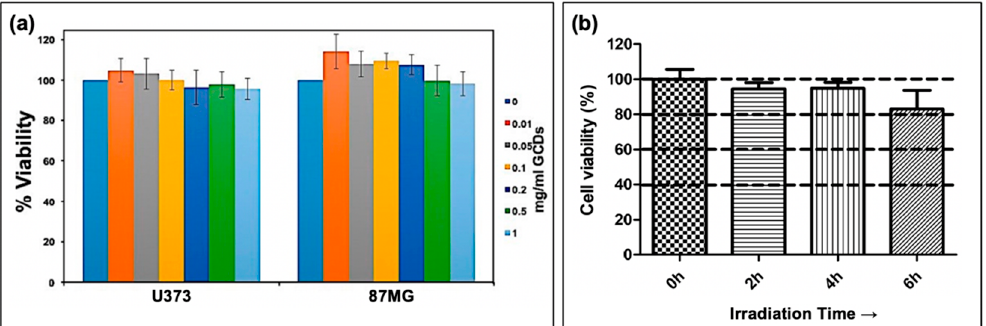
Figure 14. Example cytotoxicity data from carbon nanodot samples. ( a ) Concentration-dependent viability of Glioblastoma cell lines (U373 and 87MG) treated under dark conditions with carbon nanodots (GCD) at varying concentrations. Results demonstrate no significant cytotoxicity from carbon nanodot exposure. ( b ) Viability of NIH / 3T3 cells exposed to carbon nanodots under light irradiation intervals. Results demonstrate the condition-dependent cytotoxicity of carbon nanodots. For additional details regarding the reported studies, the reader is referred to Table 2 of the main text. Permissions